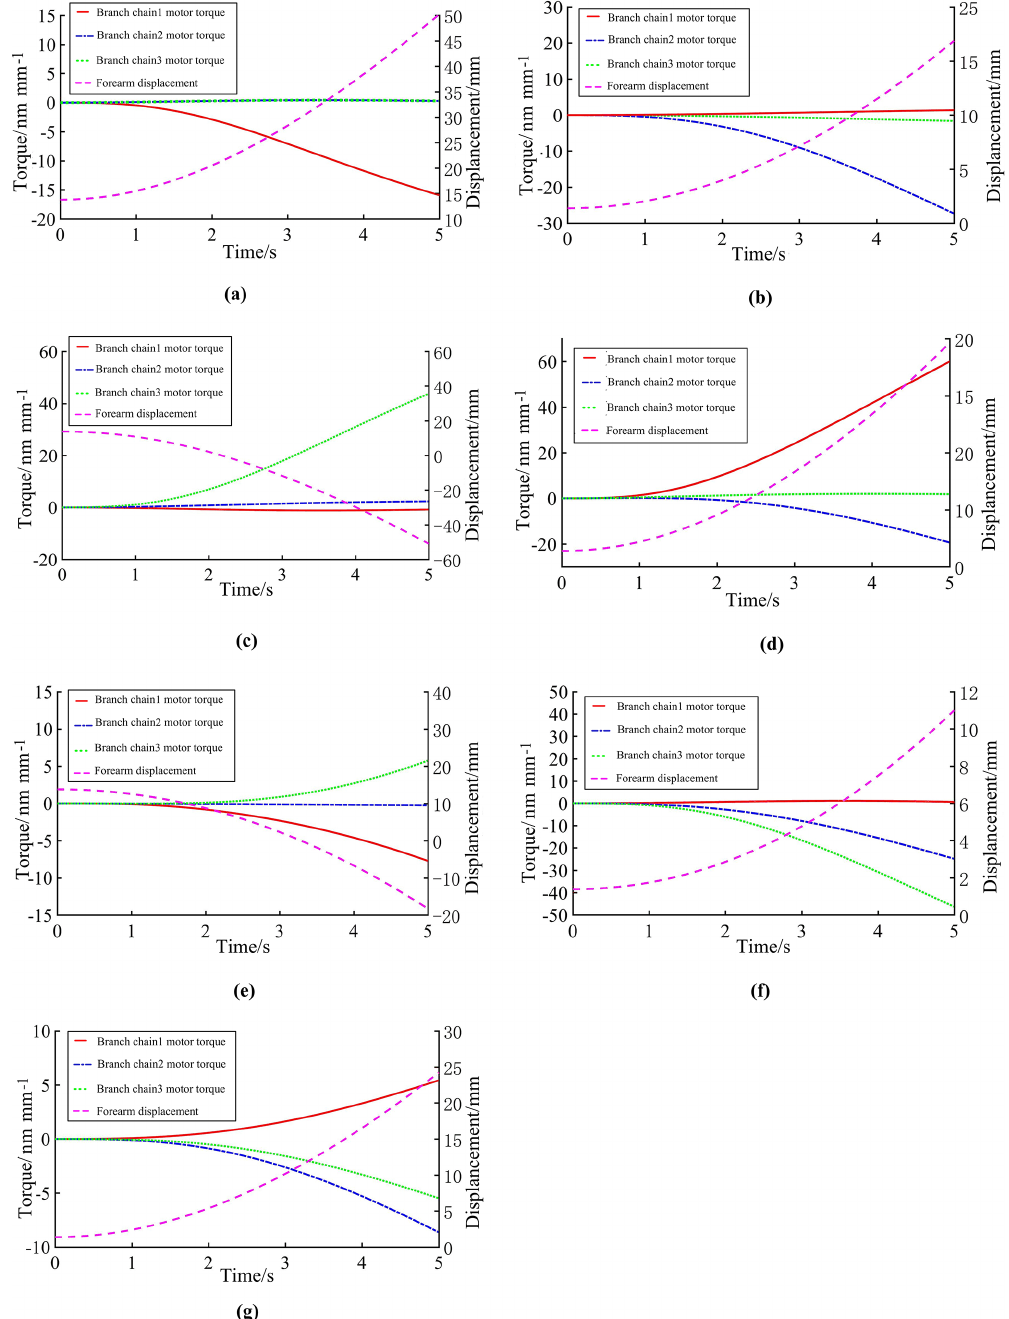
Figure 8. Changes of forearm displacement during wiring of winding robot. (a) Simulation results of branch chain 1 as the source power. (b) Simulation results of branch chain 2 as the source power. (c) Simulation results of branch chain 3 as the source power. (d) Simulation results of branch chain 1 and 2 as the source power. (e) Simulation results of branch chain 1 and 3 as the source power. (f) Simulation results of branch chain 2 and 3 as the source power. (g) Simulation results of branch chain 1, 2 and 3 as the source